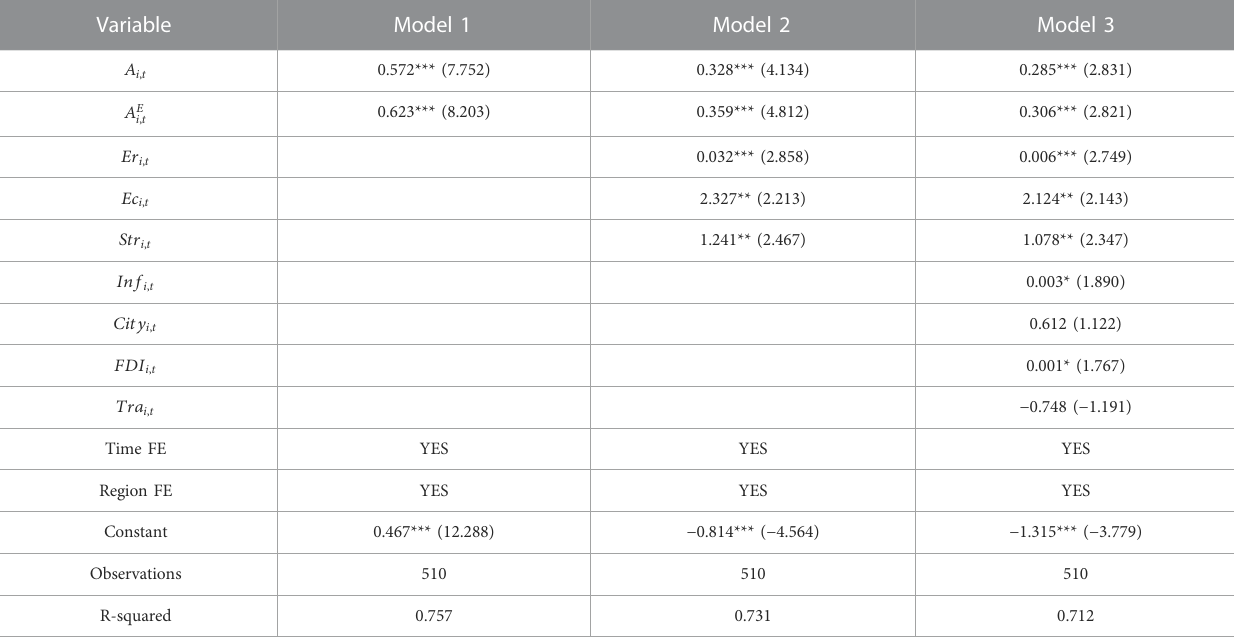
TABLE 3 Baseline regression results of the impact of technical progress on carbon productivity in China ’ s service